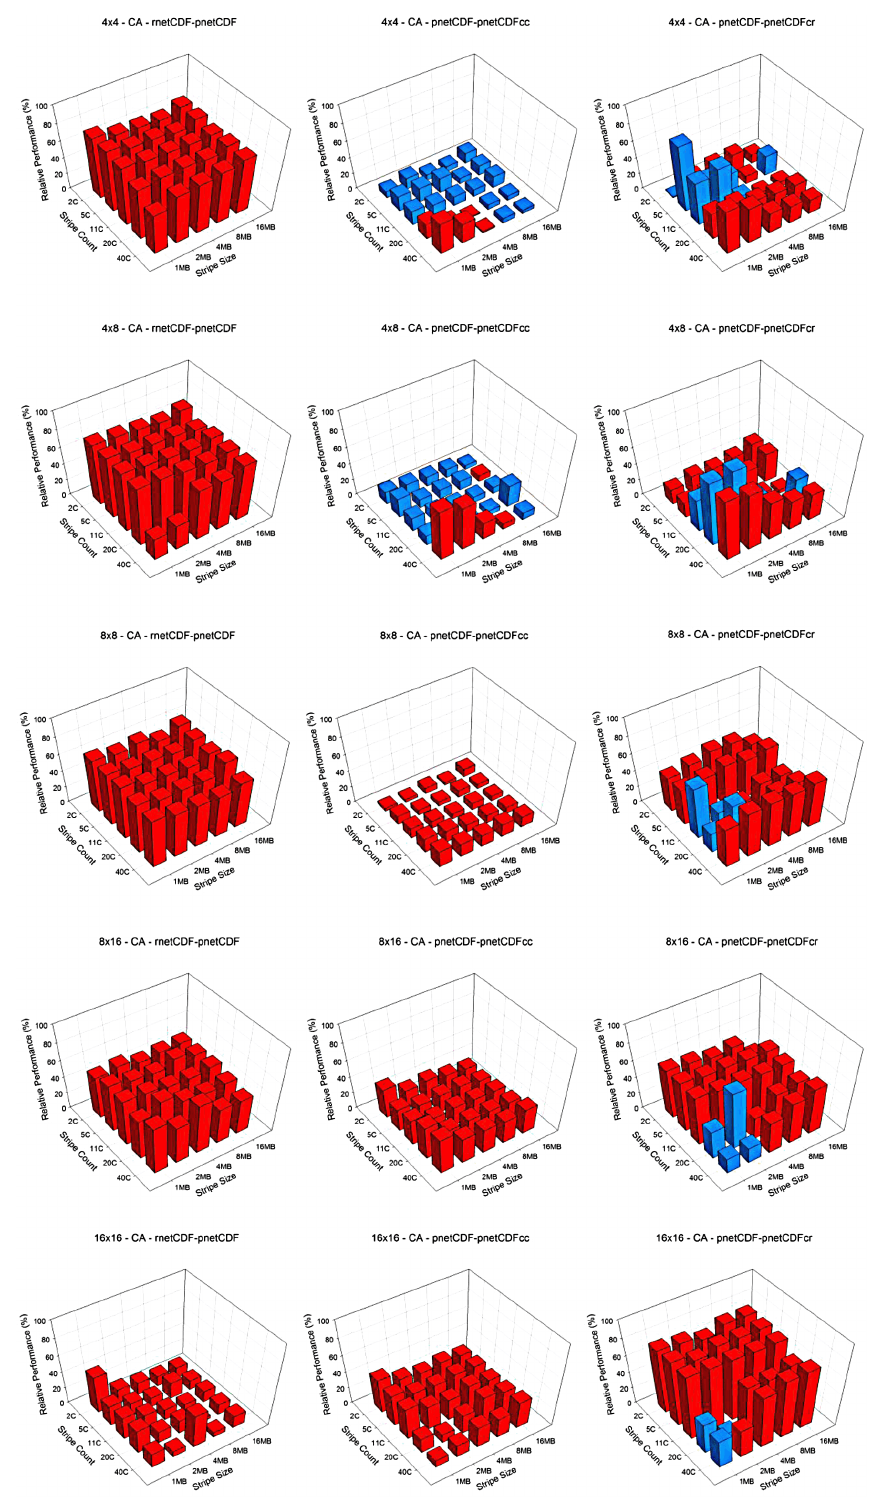
Figure 3. Relative I/O performance of pnetCDF to rnetCDF, and pnetCDFcc and pnetCDFcr to pnetCDF on the CA domain with 4 × 4, 4 × 8, 8 × 8, 8 × 16, and 16 × 16 processor configurations from Kraken. Red color denotes positive value in relative performance while blue color denotes negative value in relative